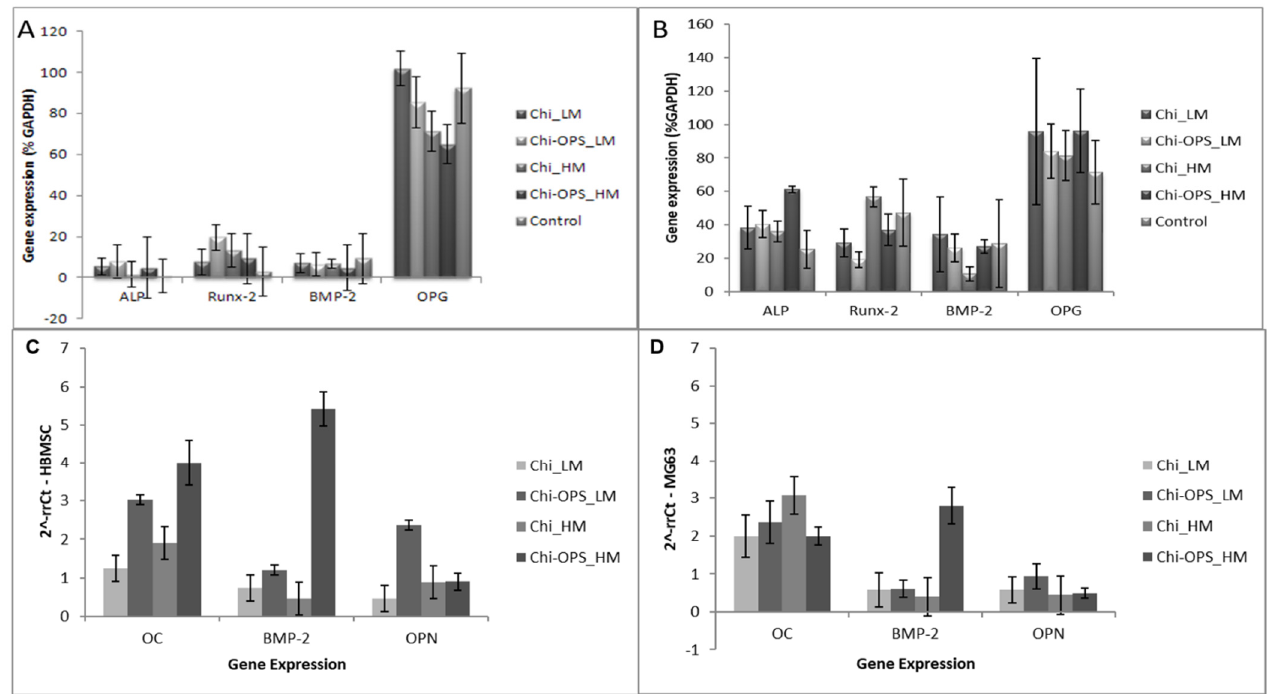
Figure 12. RT-PCR results after 21 days of HBMSCs ( A ) and MG63 ( B ) cells culture under the osteoinductive condition. ( C , D ) qPCR of the HBMSC osteogenic gene expression (osteocalcin—OC; Bone morphogenetic protein 2—BMP-2; Osteopontin—OPN) after 21 days. The 2 − rrCt method was used with the expression of the GAPDH gene as an endogenous reference. cDNA from HBMSC (C) and MG63 (D) cells grown in TCPS (P4) were evaluated as a negative control (Ref-1).